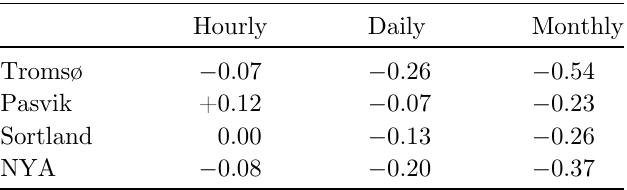
Table 1. Correlation coef fi cient for hourly, daily and monthly values of wind and solar